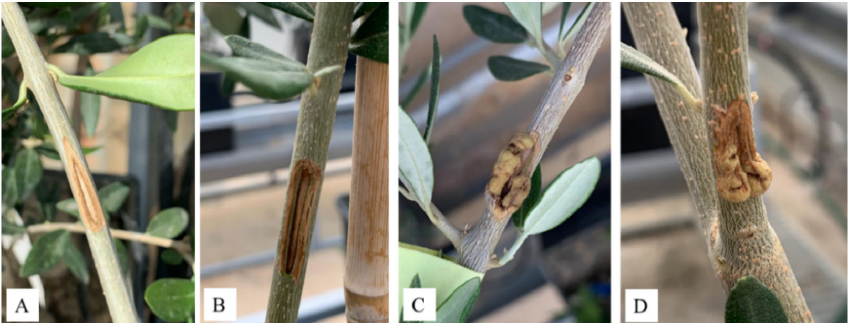
Figure 7. Appearance of symptoms of olive knot disease six months post inoculation by Pseudomonas ST1 and Pantoea paga strains ( A ) control plants; ( B ) plants inoculated with Pantoea paga strain; ( C ) plants inoculated with Pseudomonas ST1 strain; and ( D ) plants inoculated with a mixture of both bacteria.